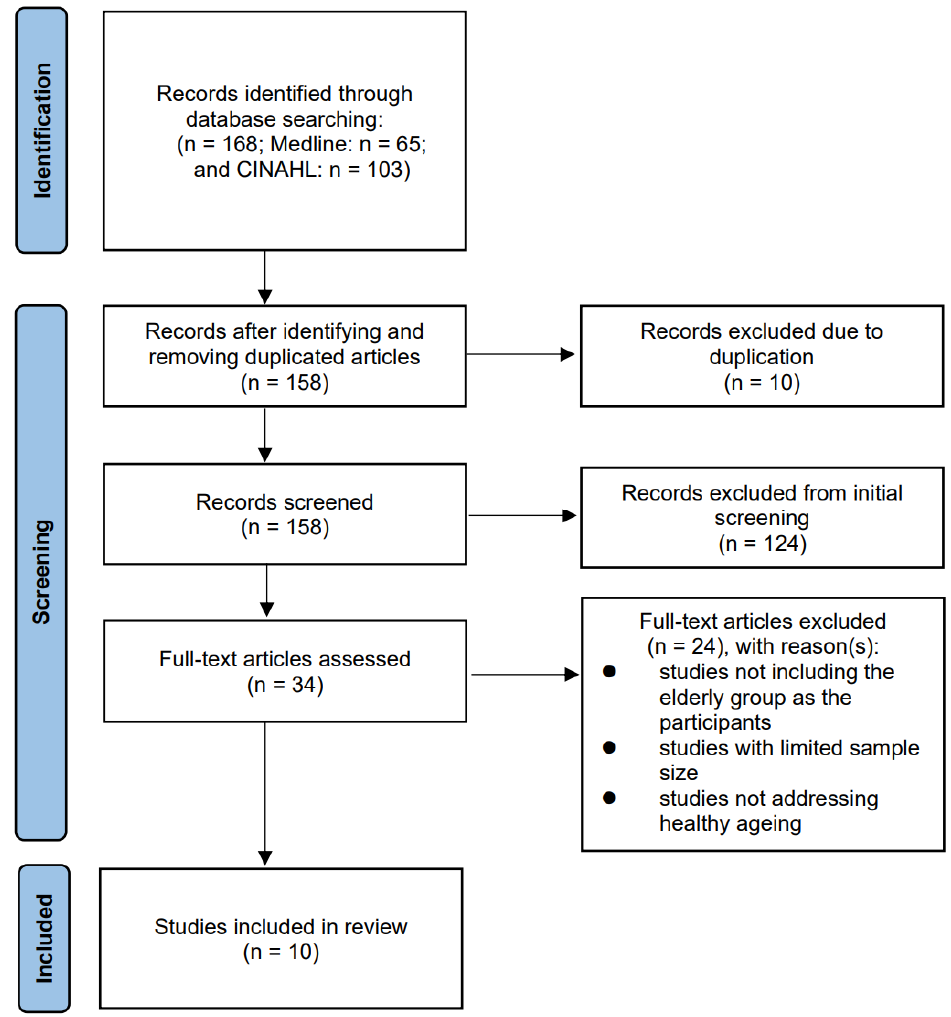
Figure 1. PRISMA flow diagram highlighting the study selection process.